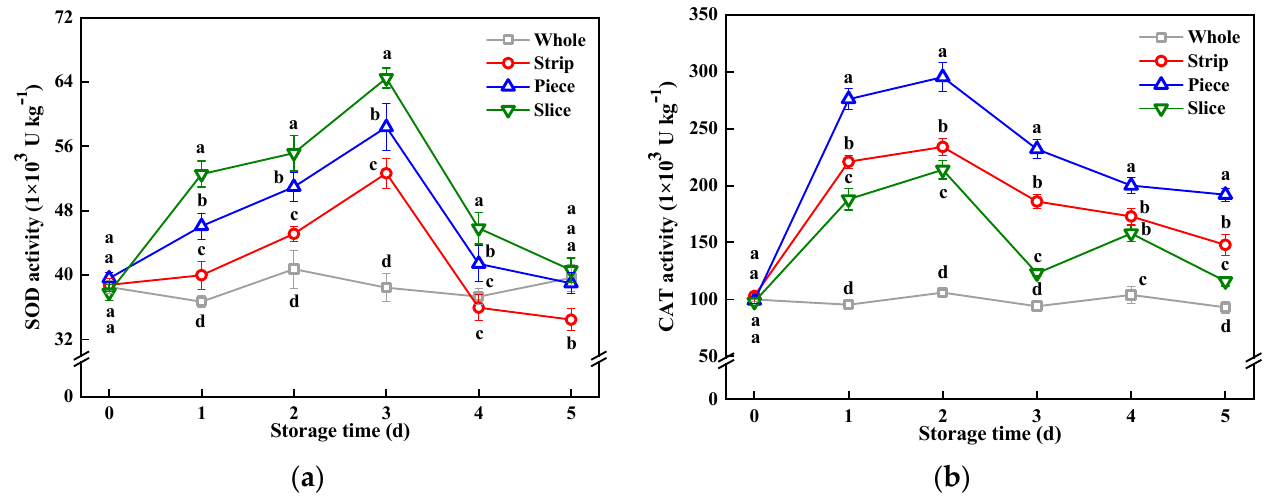
Figure 6. Effect of cutting methods on superoxide dismutase (SOD) ( a ) and catalase (CAT) activity ( b ) in fresh − cut cucumbers. Vertical bars represent the standard deviation of the mean (n = 3). Different letters indicate significant differences between the groups ( p < 0.05).